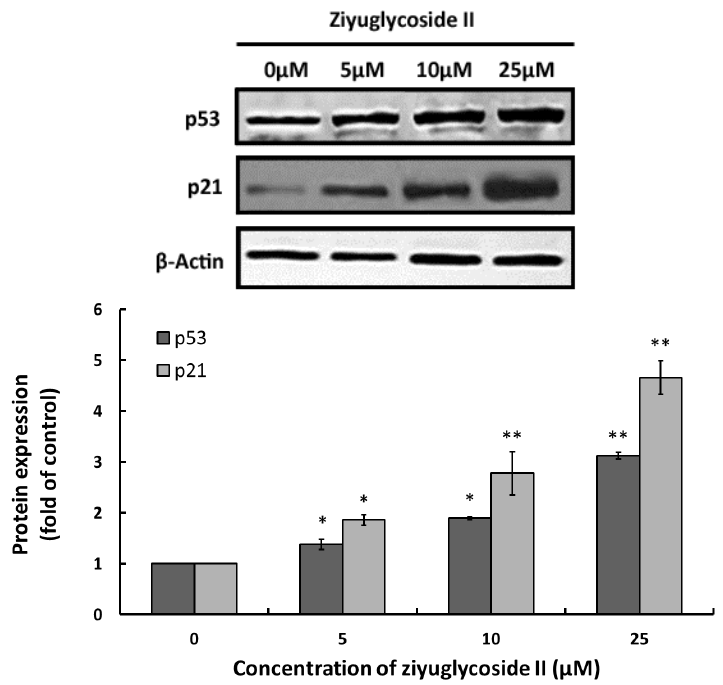
Figure 4. The effect of ziyuglycoside II on expressions of p53 and p21. Cells were incubated with various concentrations of ziyuglycoside II for 24 h and the expressions of p53 and p21 were assessed by Western blot analysis. ( Upper panel ) Immunobloting of p53 and p21, while β -actin was probed as the protein loading control; ( Lower panel ): Densitometry analysis of p53 and p21 protein expression. All data were expressed as mean ± SD of three experiments and each experiment included triplicate repeats. * p < 0.05, ** p < 0.01 vs.